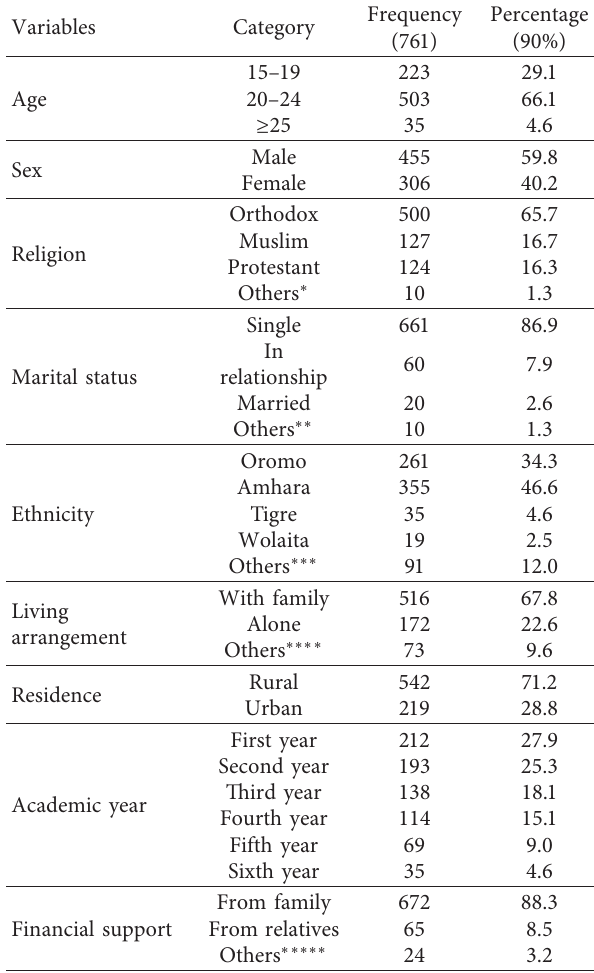
Table 1: Sociodemographic characteristics of Dilla University undergraduate students, Dilla, Ethiopia, in 2019.